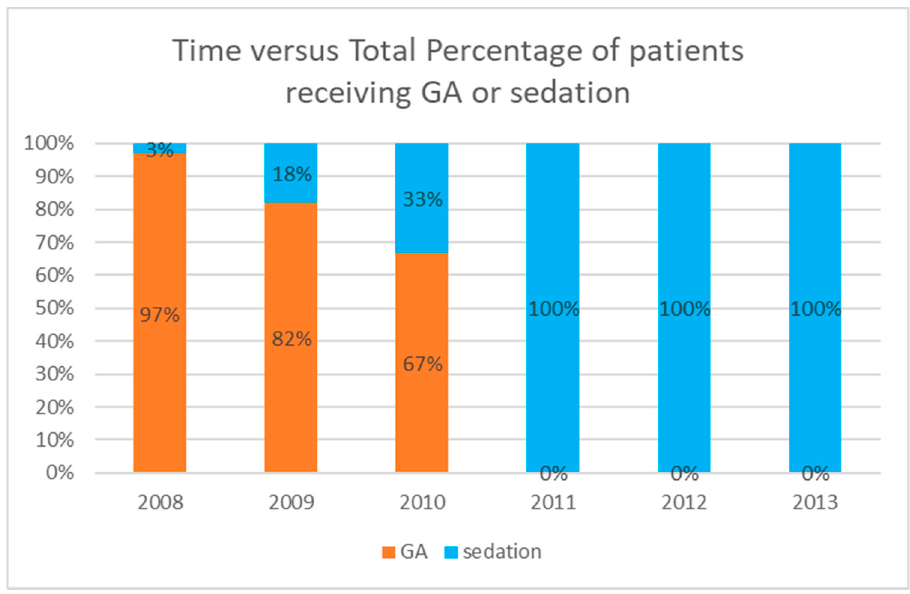
Figure 1. Chronological utilization trend between general anesthesia and sedation.